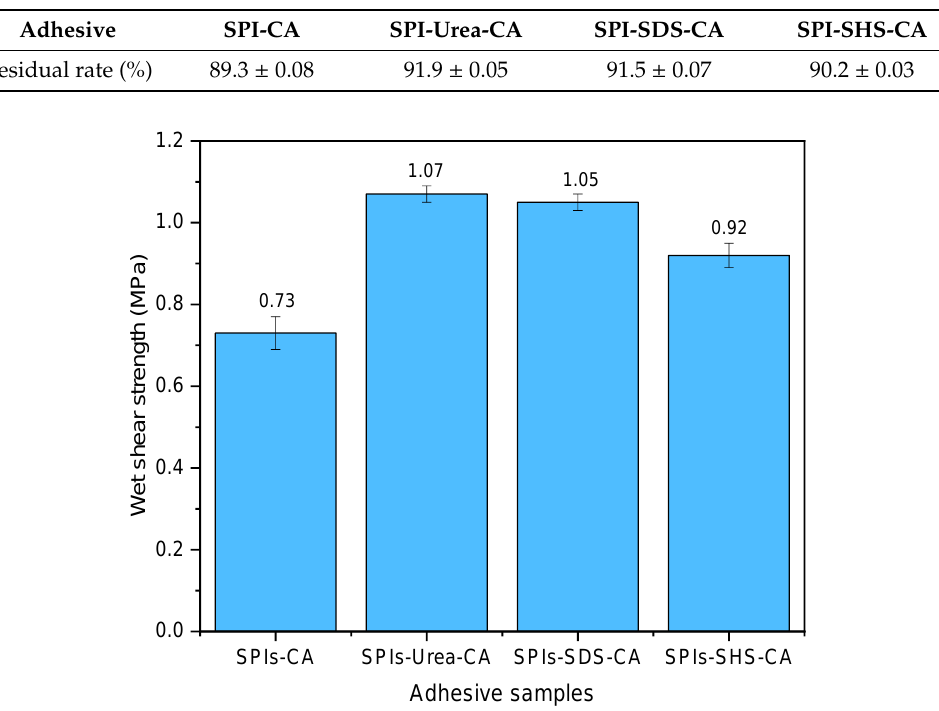
Table 4. The residual rate of the adhesive: The SPI-CA, SPI-Urea-CA, SPI-SDS-CA, and SPI-SHS-CA adhesive, respectively.